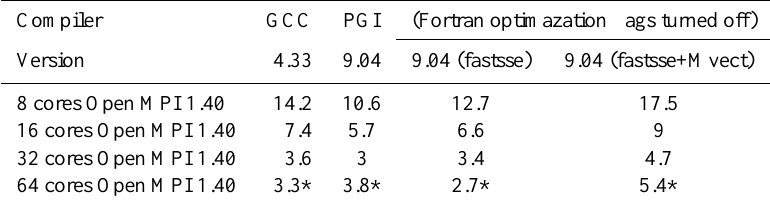
Table 2. Results for WRF 3.1.1. All results are minimal seconds needed for one of 45 model time steps of the Default January 2000 case at 3.33km horizontal resolution. The strongly varying and sometimes not reproducible ( > 5 runs) results of runs with 64 cores are marked *. Compiler GCC PGI (Fortran optimazation flags turned off) Version